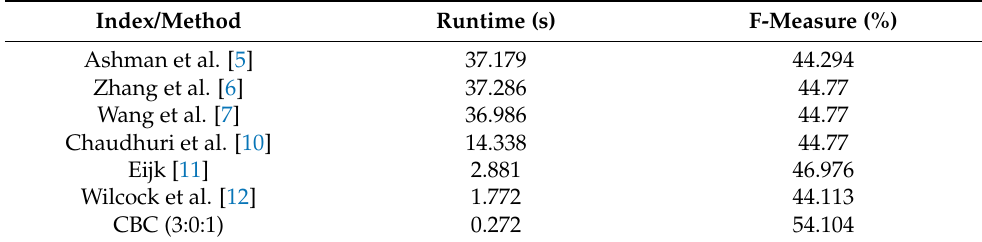
Table 5. Performance of different indices and methods on the Synthetic